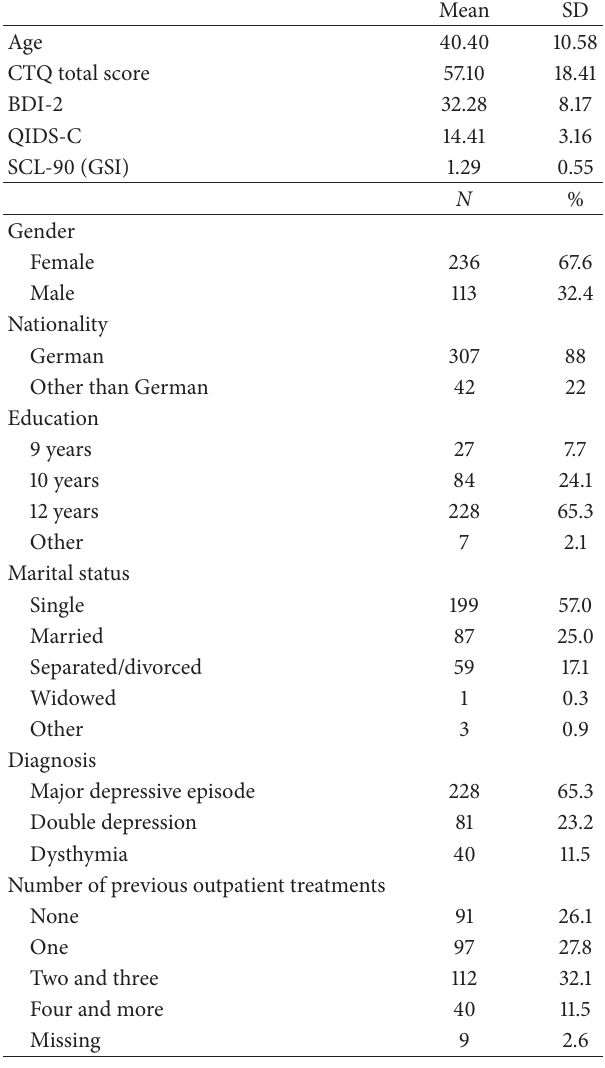
Table 1: Demographic and clinical characteristics of thesample ( 𝑛 = 349